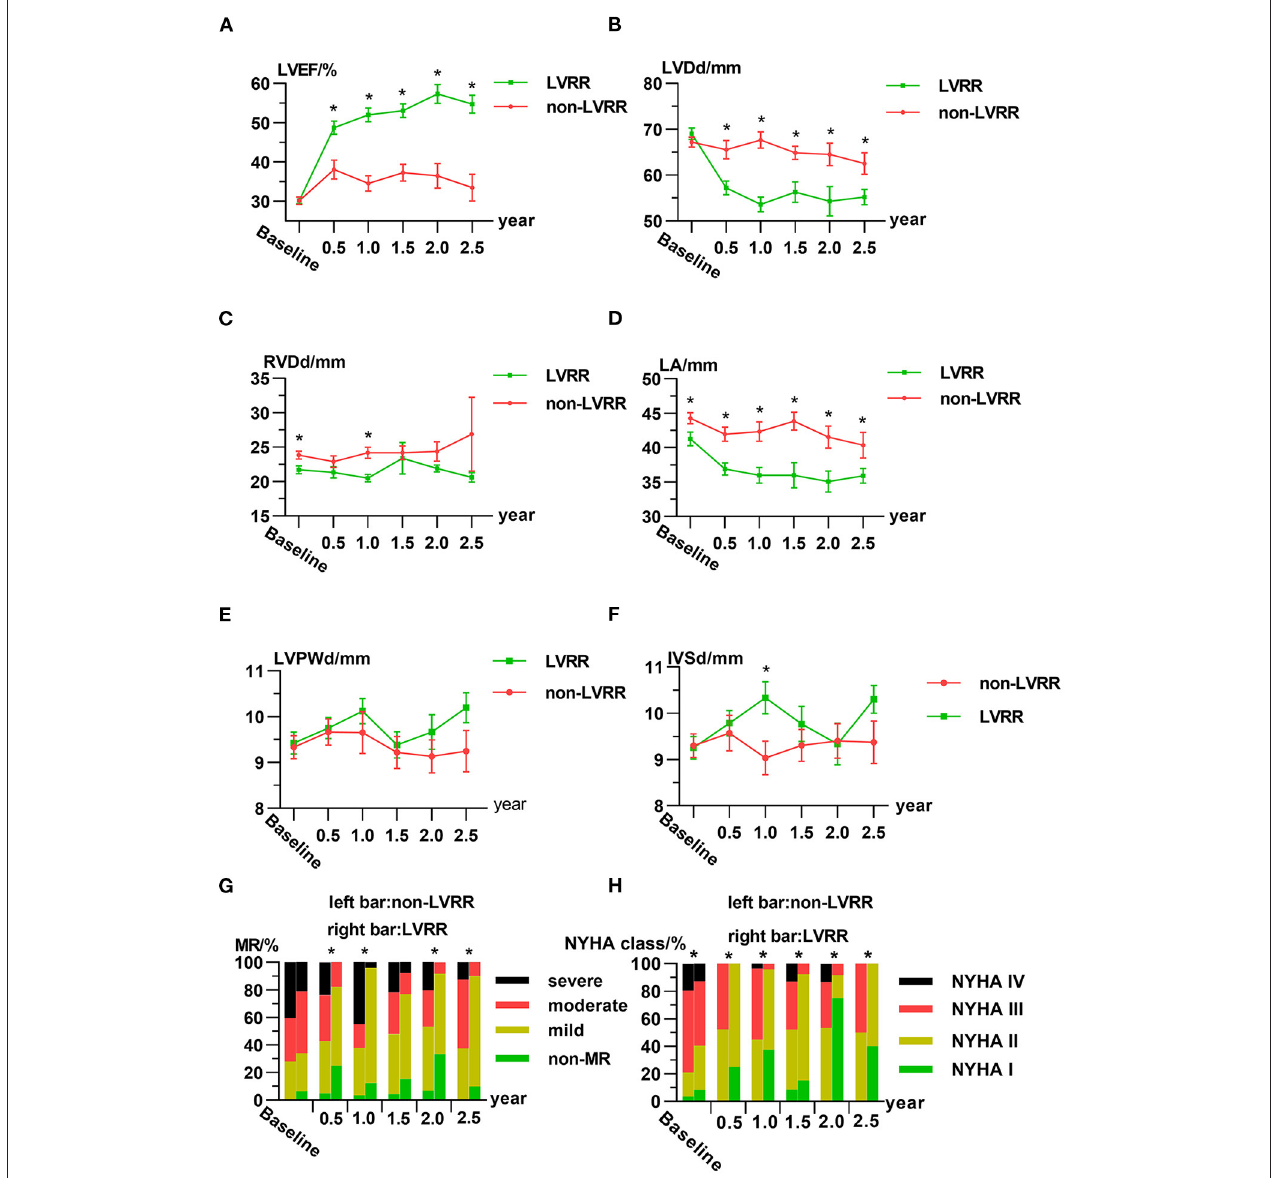
FIGURE 2 | Characteristics of the LVRR group and non-LVRR group at the first visit and return visits. Line chart for the averages of (A) LVEF, (B) LVDd, (C) RVDd, (D) LA, (E) LVPWd, and (F) IVSd. (G,H) Ratio of the severity of MR and NYHA functional class over time. The data are presented as the mean ± standard error (A–F) . In (A–F) , * p ≤ 0.05 by non-paired Student’s t -test between two groups. In (G) , * p ≤ 0.05 comparing the percentage of patients who are above moderate or severe in both groups by chi-square test. In (H) , * p ≤ 0.05 by Mann–Whitney U -test. IVSd, interventricular septal dimension; LA, left atrial dimension; LVDd, left ventricular end-diastolic dimension; LVEF, left ventricular ejection fraction; LVPWd, left ventricular posterior wall dimension; LVRR, left ventricular reverse remodeling; MR, mitral regurgitation; NS, no statistically significant difference; NYHA, New York Heart Association; RVDd, right ventricular end-diastolic